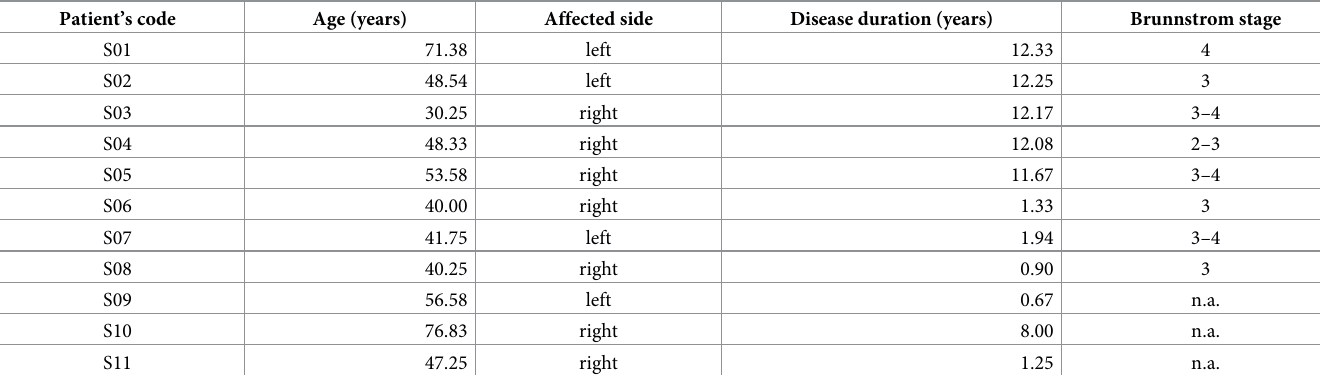
Table 1. Patient